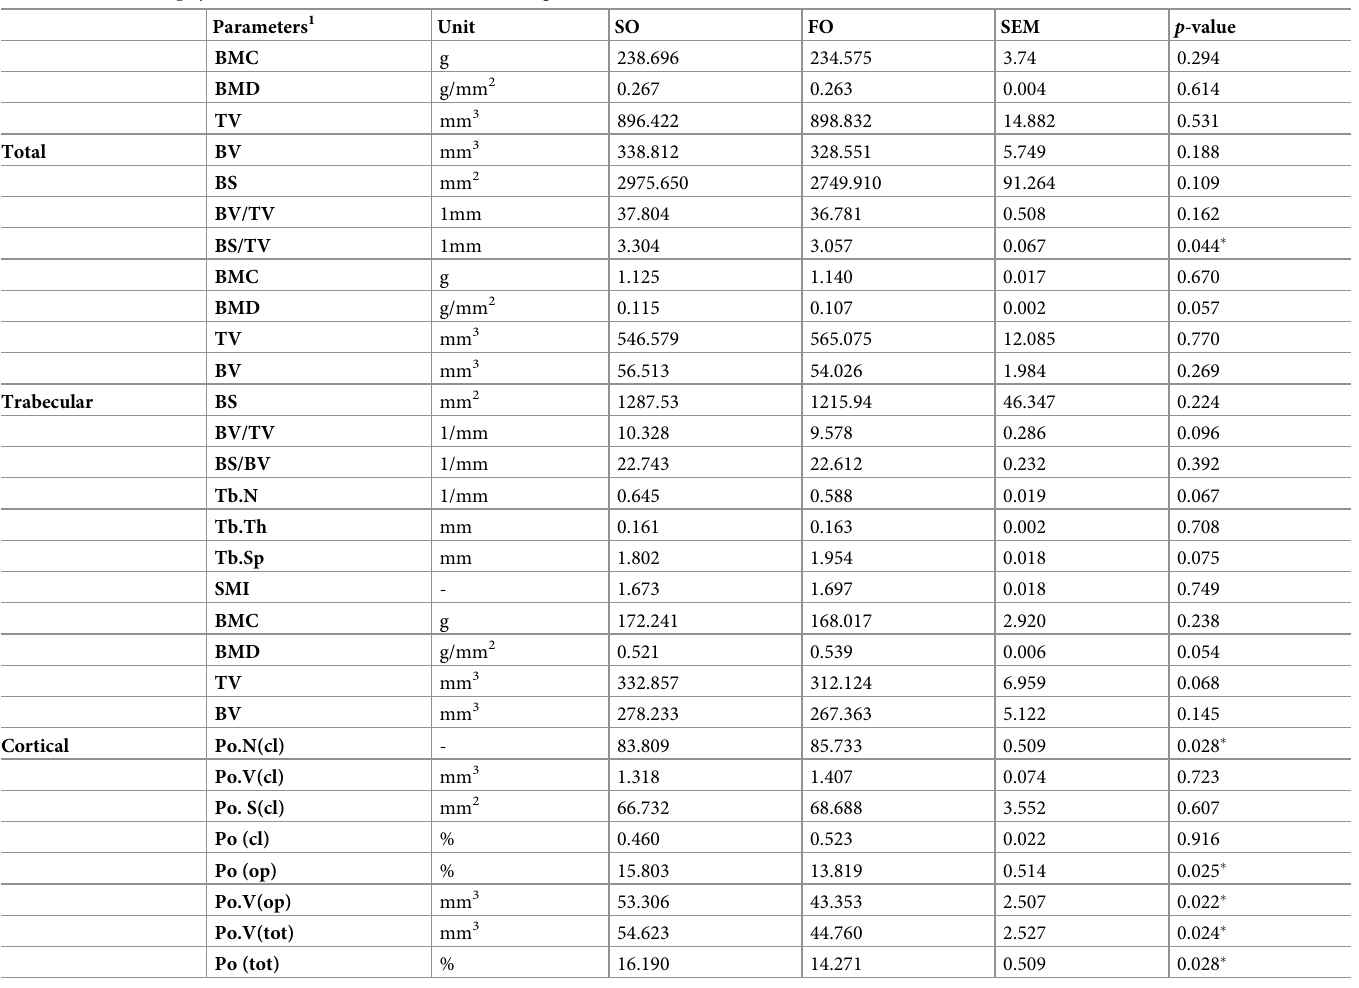
Table 5. Femur metaphysis section 3D structure data at market-age